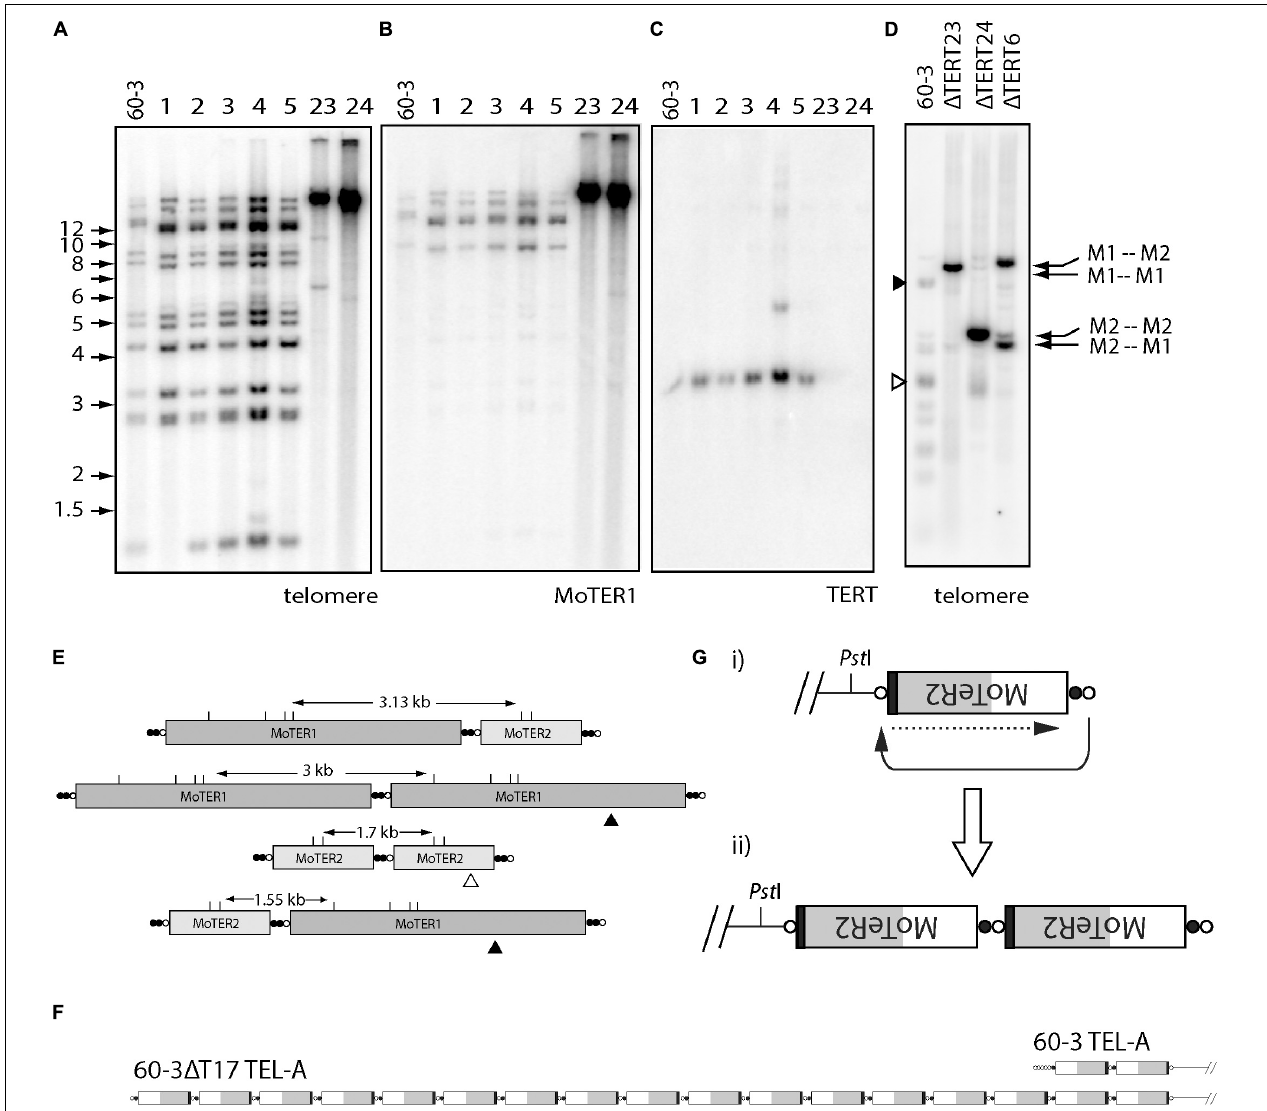
FIGURE 5 | Alternative telomere maintenance (ATM) in telomerase knockout (TERT KO) mutants of strain 60-3. DNA was extracted from candidate telomerase knockout strains, digested with Pst I, size-fractionated by gel electrophoresis, and blotted to a membrane. Shown are phosphorimages obtained after sequential hybridization with PCR-generated, 32 P-oligolabeled probes for panels (A,D) telomere repeats, (B) MoTeR1, and (C) TERT. Note the absence of parental telomeric fragments in the TERT KO isolates 60-3 (cid:49) T23 and 60-3 (cid:49) T24; and their replacement by intensely hybridizing, high molecular weight fragments. (C) shows successful TERT deletion in strains 23 and 24; and (D) shows phosphorimage of a gel-fractionated Mbo I digest of DNA TERT KO strains 60-3 (cid:49) T6, 60-3 (cid:49) T23 and 60-3 (cid:49) T24, after hybridization with the telomere probe. Again, note the absence of the parental telomeric fragments and their replacement by intensely hybridizing, yet discrete, Mbo I fragments, whose sizes correspond to specific MoTeR-MoTeR junctions (E) . (E) Diagram showing how different tandem MoTeR arrangements cause the interstitial telomeres to be contained on different-sized Mbo I fragments. Telomeric and telomere-like (present at MoTeR 5 (cid:48) ends) sequences are shown as white and black circles, respectively; Mbo I sites are marked as “M.” (F) Example of MoTeR array amplification in TERT KO strain 60-3 (cid:49) T17, compared with the 60-3 parent strain. (G) Diagram showing how D-loop formation and telomere attrition-induced repair can result in the generation of tandemly amplified MoTeR arrays at the chromosome ends. The compromised telomere loops back and invades the interstitial telomere sequence (black arrow) and copies the distal sequence (dotted arrow). Repeated iteration of this process can generate extended